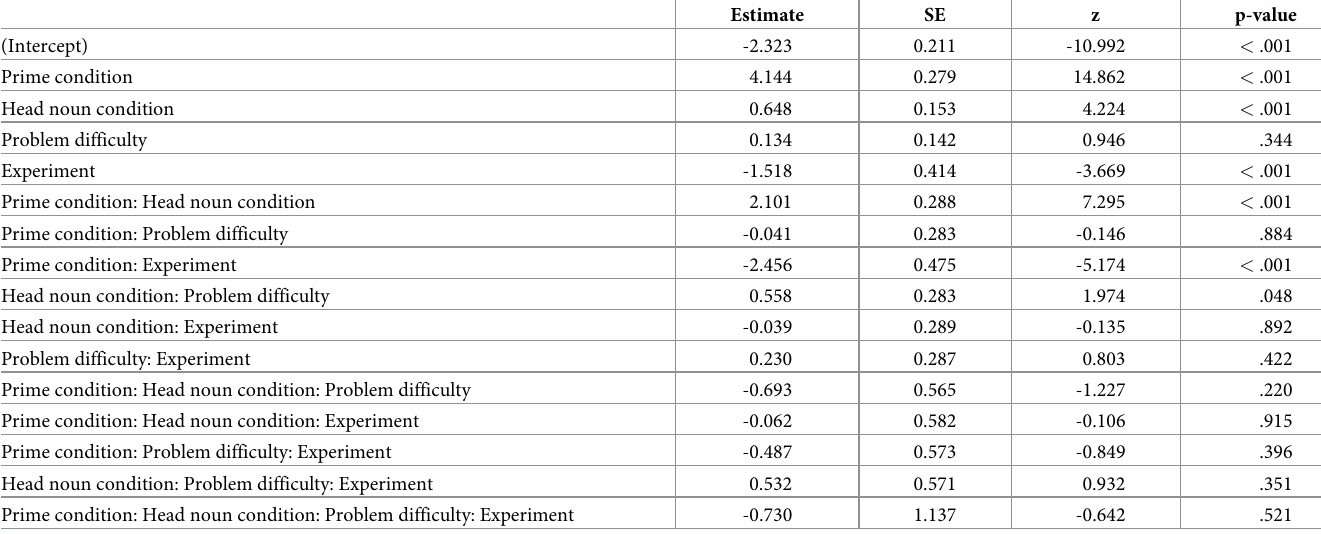
Table 4. Fixed effect estimates (in log odds units), cross experiment analysis (1a and